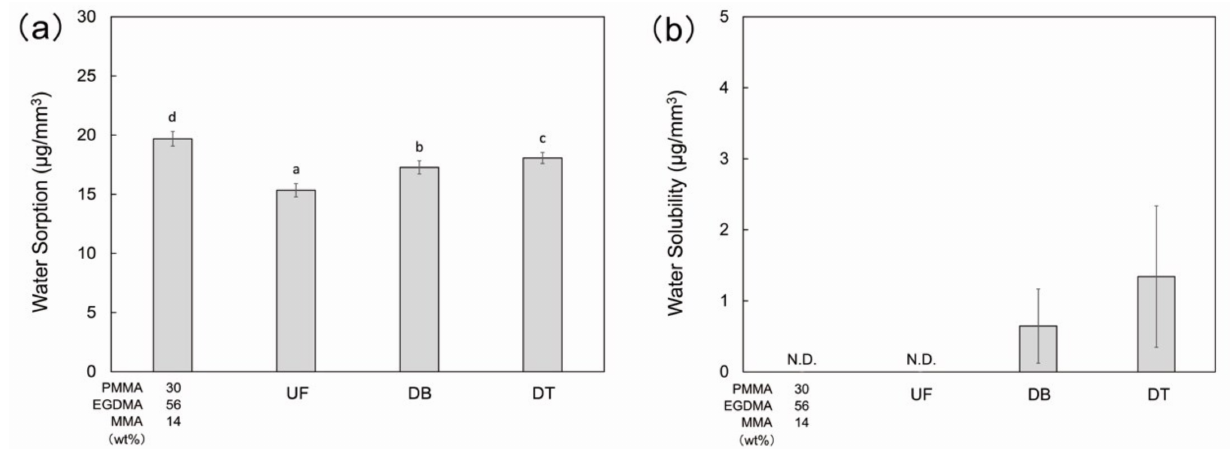
Figure 6. Physicochemical properties of the printable PMMA-based resin P30E56M14, conventional PMMA (UF), and commercial 3D-print resins (DB and DT); ( a ) water sorption; ( b ) water solubility. The different letters indicate significant differences between the groups ( p < 0.05, Tukey’s test, n =